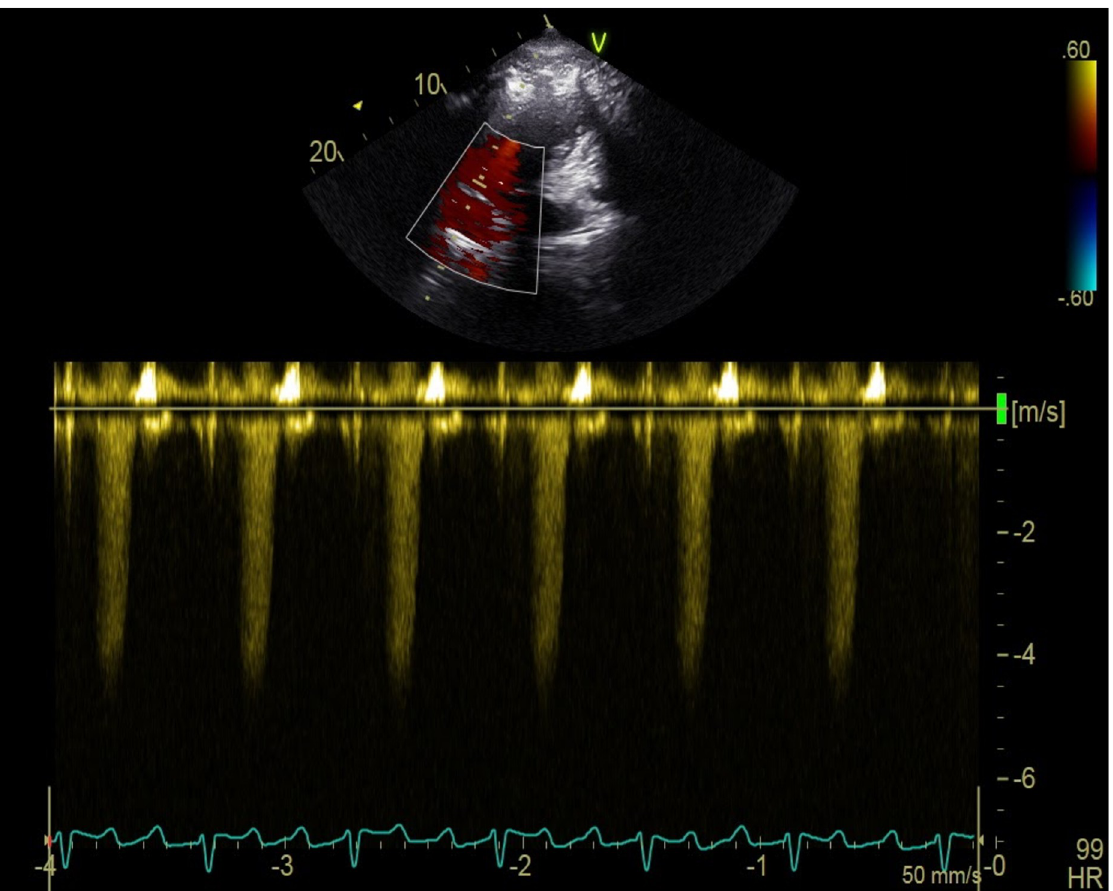
Fig 4. Pulmonary hypertension in a BB dolphin. Continuous wave Doppler measurement of tricuspid regurgitation in an adult BB dolphin diagnosed with pulmonary hypertension.